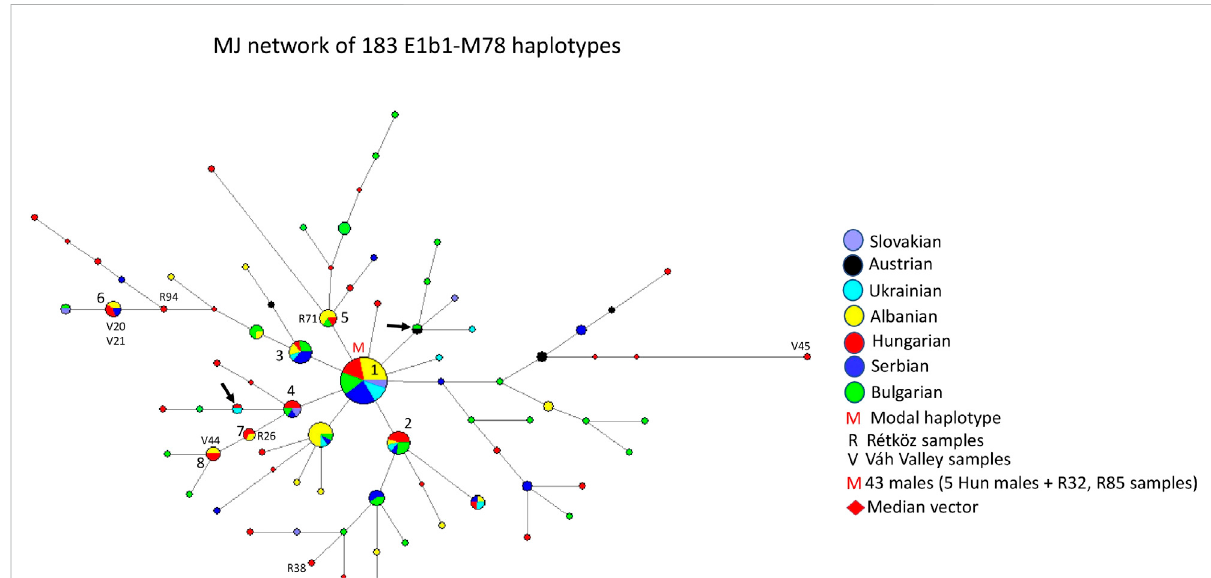
FIGURE 7 The Median-Joining Networks (MJ) of 183 E1b1-M78 haplotypes. The circle sizes are proportional to the haplotype frequencies. The smallest area is equivalent to one